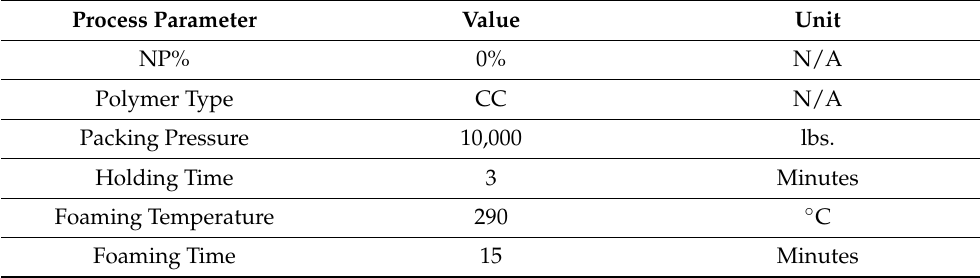
Table 5. Taguchi design of the process parameter optimum ratio and